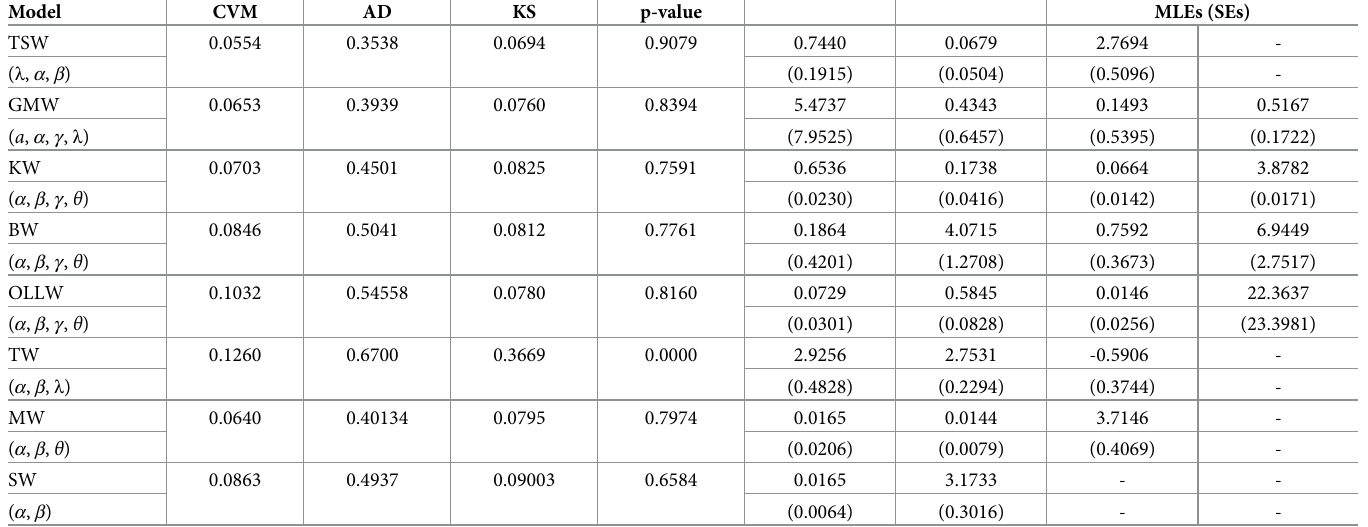
Table 3. CVM, AD, KS with p-value, MLEs and SEs for the second data set. Model